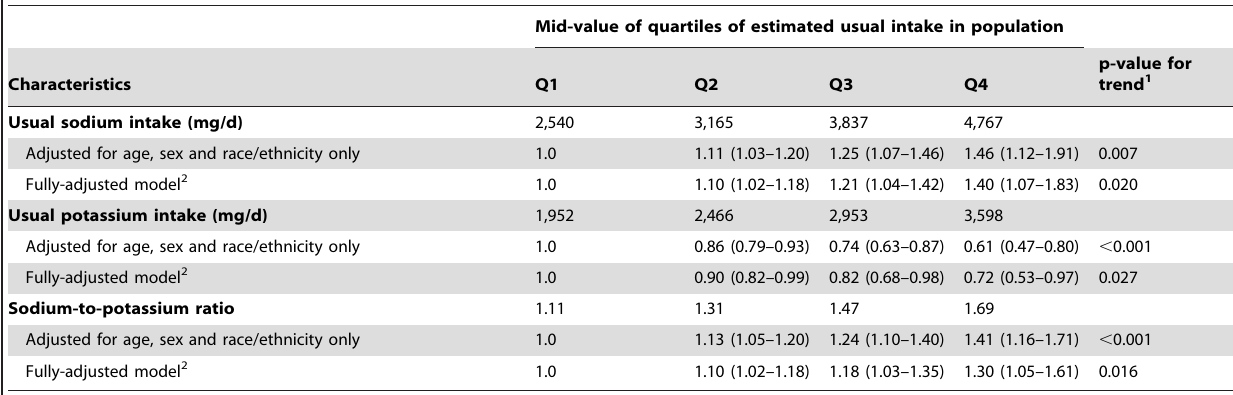
Table 4. Adjusted odds ratio (OR) of estimated usual sodium and potassium intake and their ratio for hypertension among adults aged $ 20 years who were not taking antihypertensive medication, NHANES